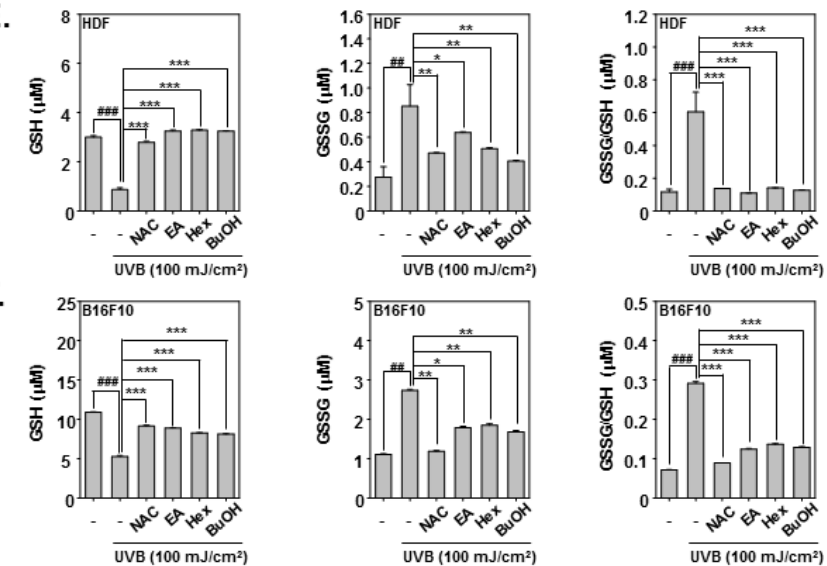
Figure 5. Antioxidant effects of YJP-EA, -Hex, and -BuOH on HaCaT, HDF, and B16F10 cells. HaCaT and HDF cells were irradiated with UVB; B16F10 cells were stimulated by α -MSH. We then treated them with NAC (3 mM) for 15 min or with YJP-EA, -Hex, and -BuOH (50 µ g/mL) for 12 h. ( A – C ) The ROS production was analyzed by flow cytometer. ( D – F ) The GSH and GSSG levels were measured, and the GSSG/GSH ratio was evaluated in both cells. All experiments were performed individually in triplicate. ### p < 0.001 vs. non-treated (NT) cells, ## p < 0.01 vs. non-treated (NT) cells, *** p < 0.001 vs. UVB or α -MSH-stimulated cells, ** p < 0.01 vs. UVB or α -MSH-stimulated cells, and * p < 0.05 vs. UVB or α -MSH-stimulated